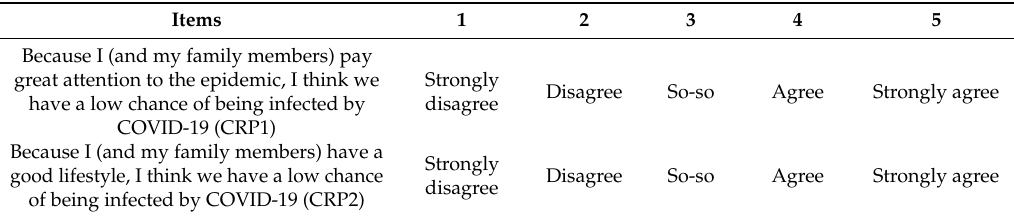
Table A4. Scale to measure cognitive risk